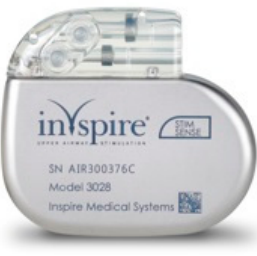
Figure 4. The Inspire generator.